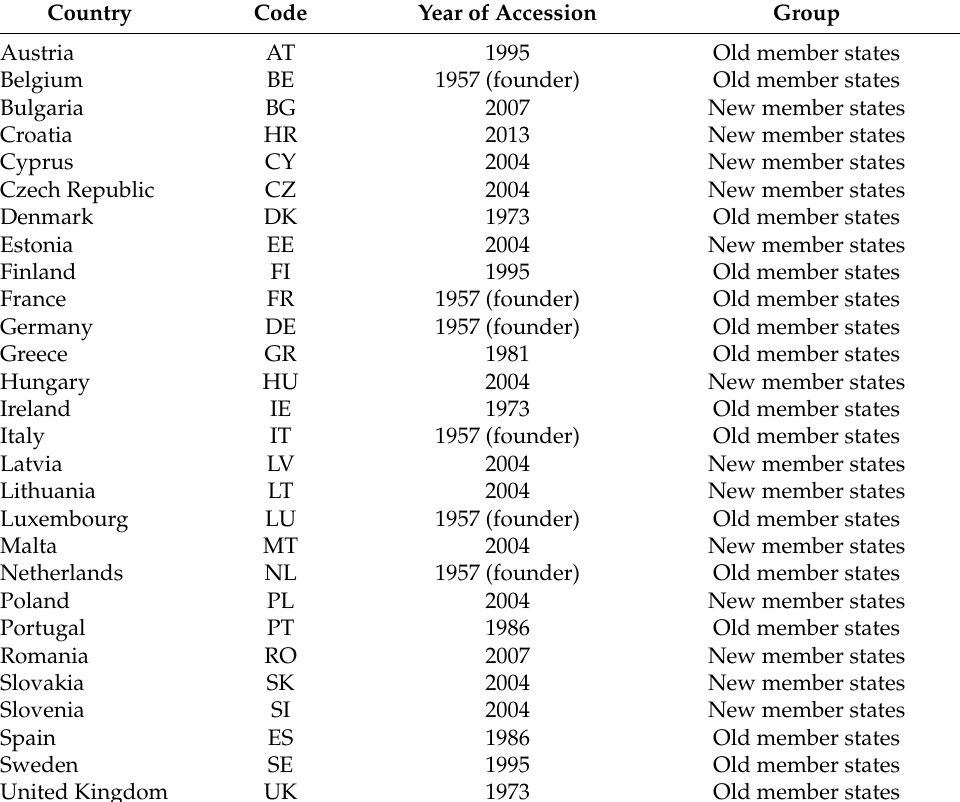
Table A1. List of countries included in the sample.